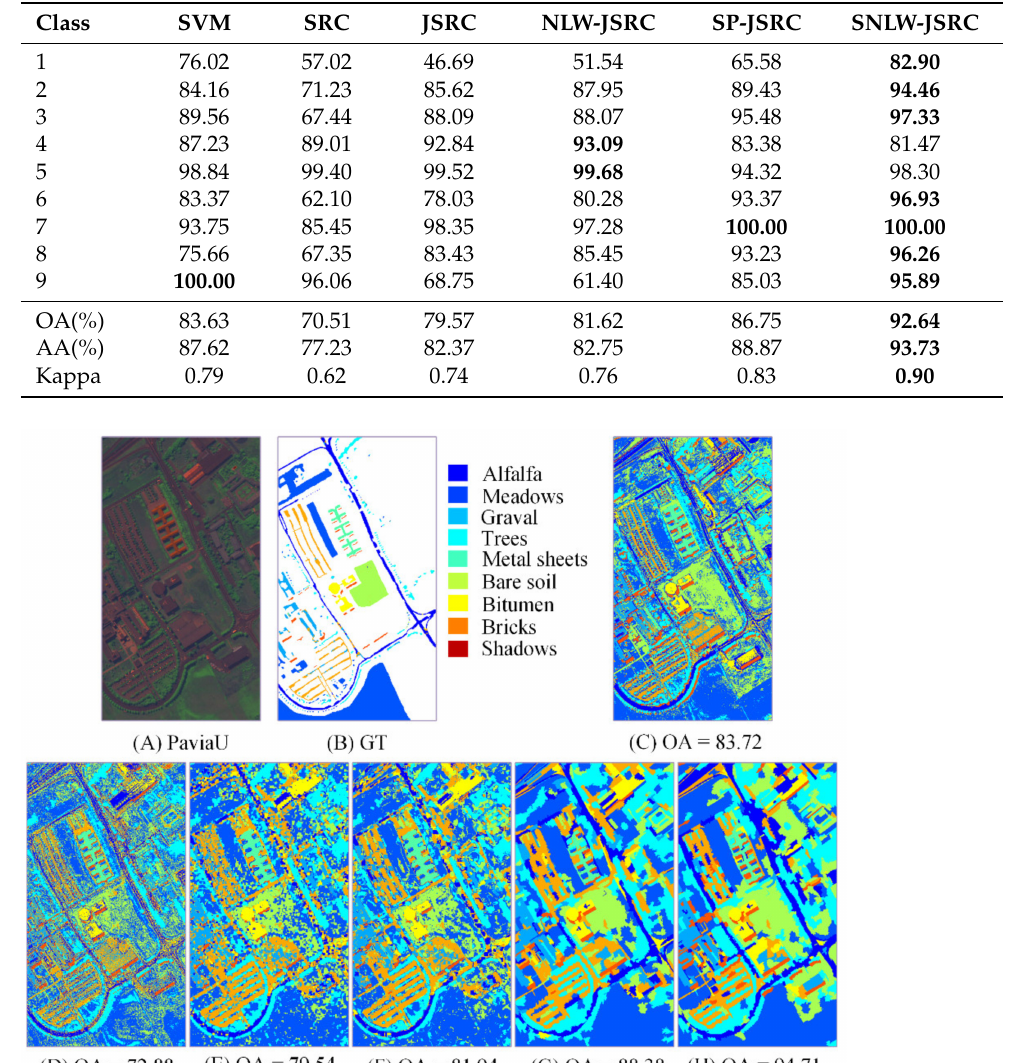
Table 4. Accuracy of PaviaU classification results (the best result in each row is highlighted in bold).